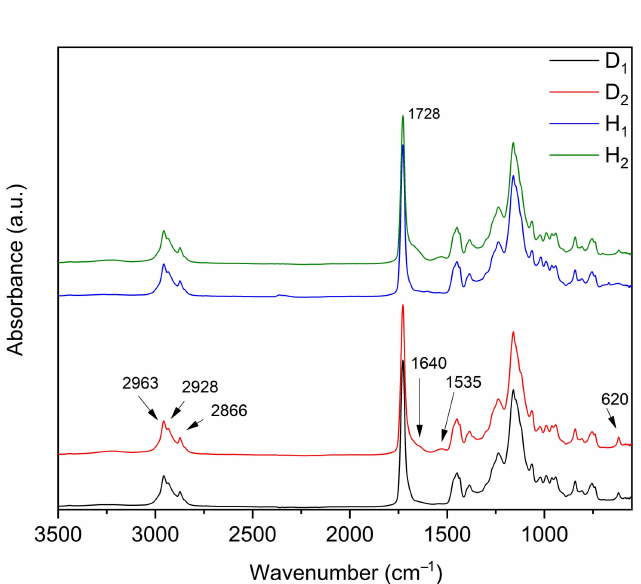
Figure 1. FT-IR absorption spectra of fluorine-free copolymer samples of Series 1 and